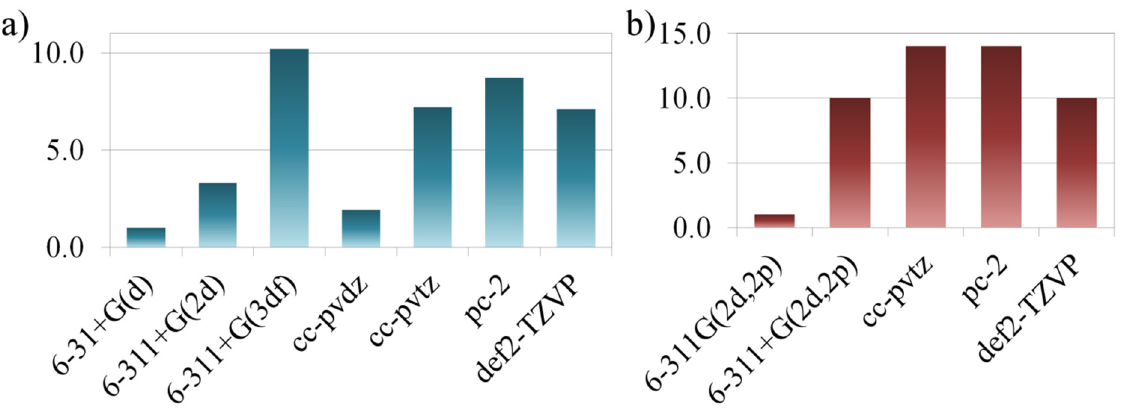
Figure 4. Relative time spent for 22 using different basis sets at the geometry optimization stage ( a ) and calculation of 31 P shift ( b ).